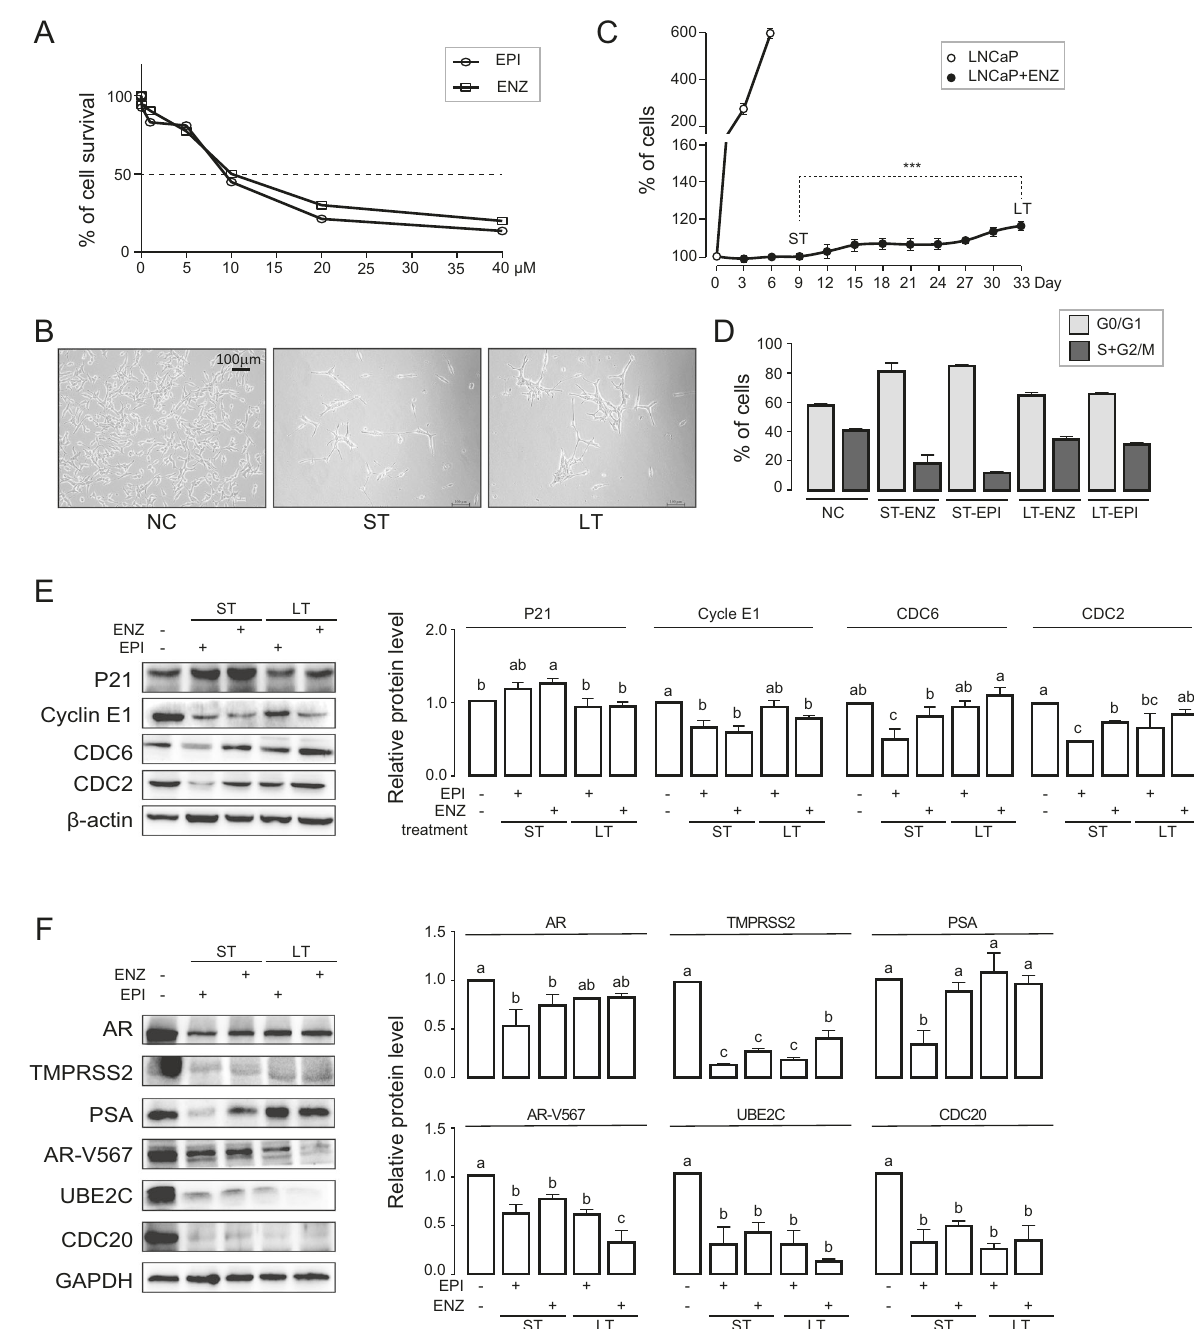
Fig. 1 AR inhibitor-resistant prostate cancer cell model is established. A 6*10 3 cells were plated in 96-well plates and treated with various concentrations of ENZ and EPI for 48 h. The survival curve was detected by CCK8. B , C 1*10 6 LNCaP cells were plated and either untreated (negative control; NC), treated with ENZ (10 µM) or EPI (8 µM) with normal FBS media change every 3 days for a total of 9 days (short-term treatment, ST) and for 33 days (long-term treatment, LT). Representative microscopic images ( B ) and cell proliferation curve ( C ) are shown. Data were expressed as mean ± std. of biological triplicates; Student ’ s t -test were performed; * p < 0.05. D Cells from NC, ST-EPI, ST-ENZ, LT-EPI, and LT-ENZ were analyzed for cell cycle distribution by FACS. E Levels of cell cycle markers are quanti fi ed in NC, ST, or LT cells by WB. β -actin protein is used as loading control. One-way ANOVA with Turkey test, p < 0.05. Data are expressed as mean ± std of biological triplicates. F Levels of AR, AR target (TMPRS2, PSA), AR-V567, AR-Vs target (UBE2C, CDC20) proteins in NC, ST-EPI, ST-ENZ, LT-EPI, and LT-ENZ were quanti fi ed by WB. GAPDH protein was used as loading control. One-way ANOVA with Turkey test, p < 0.05. Data are expressed as mean ± std of biological triplicates. sorter (FACS) analysis in ST and LT cells. WB results revealed that culture medium (added the same doses of DMSO) or in the P21 (G1 phase marker, cyclin-dependent kinase inhibitor) was manually added R1881 culture medium (Figure S1B, C). upregulated in ST and backed down in LT cells, and Cyclin E1 (G1- We next examined markers of cell cycle checkpoint by Western S phase marker), CDC6 (G1-S phase marker), and CDC2 (G1-S and Blot (WB) and cell cycle distribution by fl uorescence activated cell Cell Death and Disease (2022)